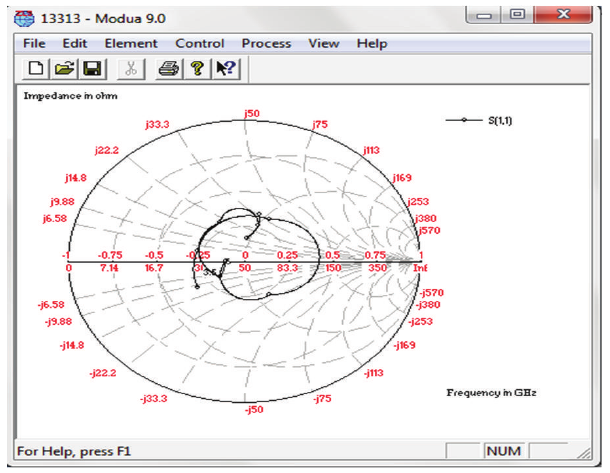
Figure 10: Smith chart for proposed antenna.